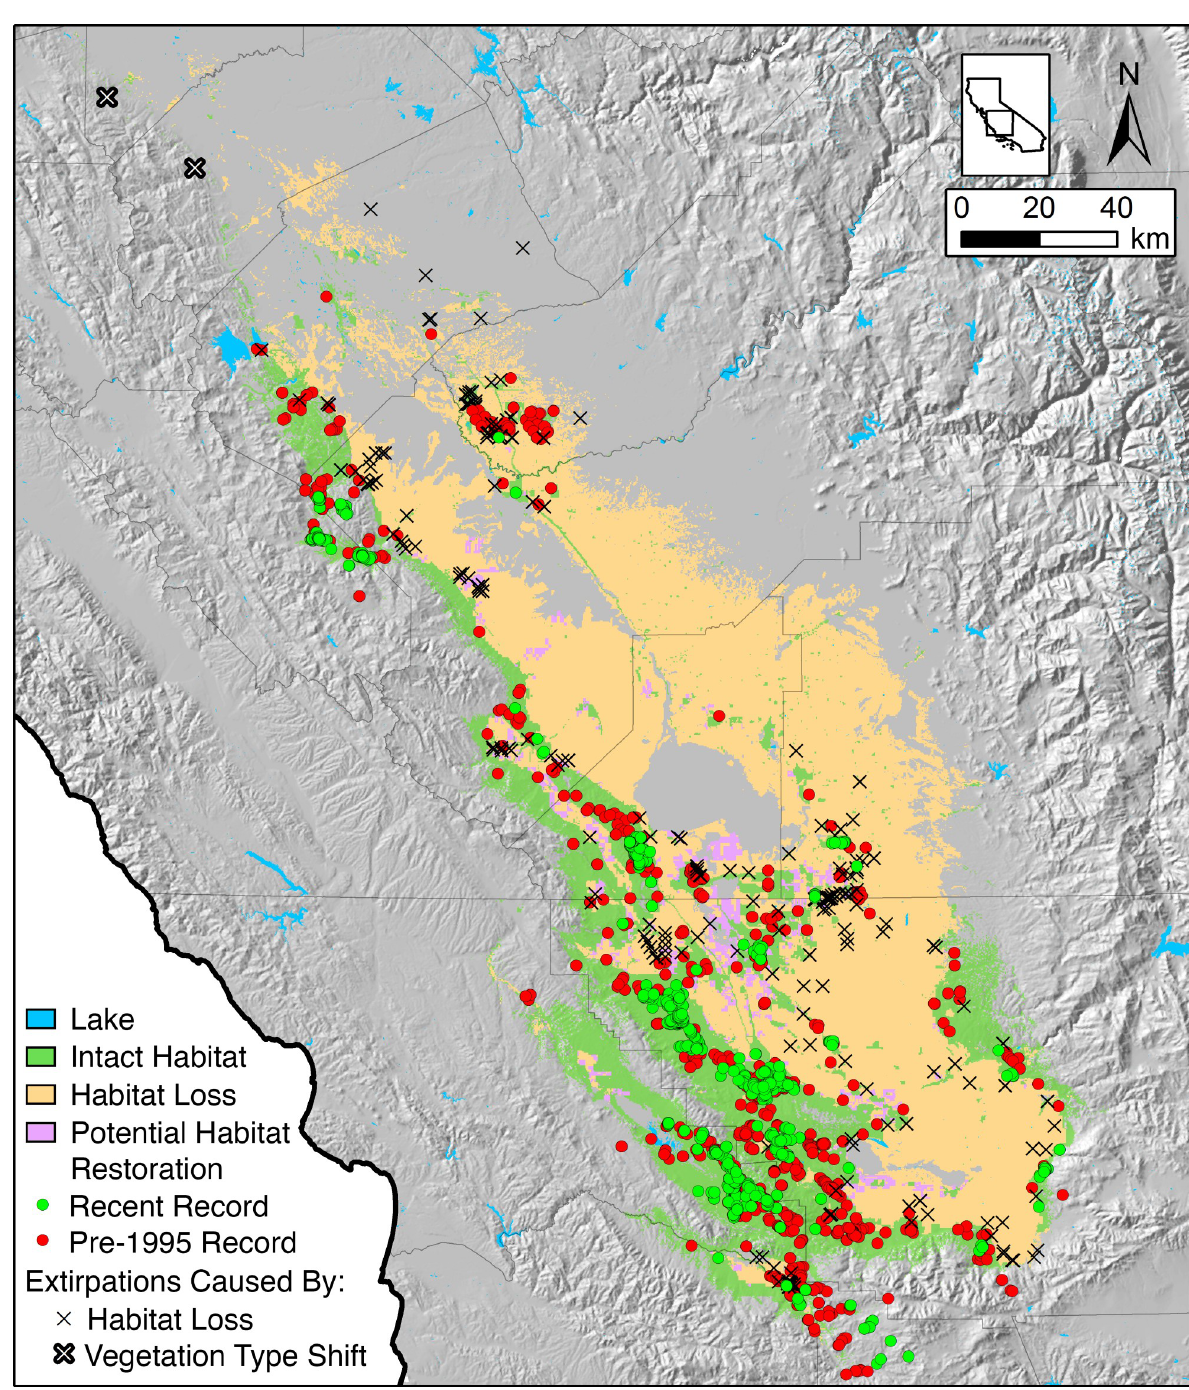
Fig 1. Changing conservation biogeography of Gambelia sila . The historical distribution of habitat for Gambelia sila , extant sites, extirpated sites, lost habitat, and sites where persistence of G . sila has not been confirmed since before 1995. Extirpations caused by vegetation type shifts are sites apparently extirpated due to dense exotic vegetation. Areas of potential habitat restoration are sites that were continuously fallow (2013–2015) and, if restored, would constitute a patch of habitat of sufficient size to have a � 90% probability of long-term population persistence. County boundaries are shown in